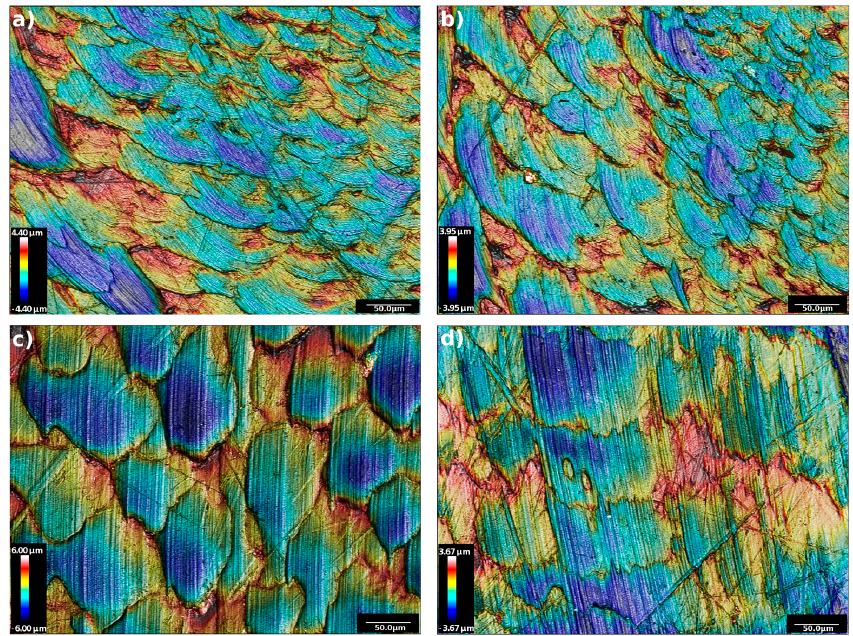
Figure 3. Contour images of the topographies acquired on the inner surfaces of four non-loaded specimens: ( a ) VE; ( b ) STD; ( c ) XL-75; ( d ) XL-50. specimens: ( a ) VE; ( b ) STD; ( c ) XL-75; ( d )